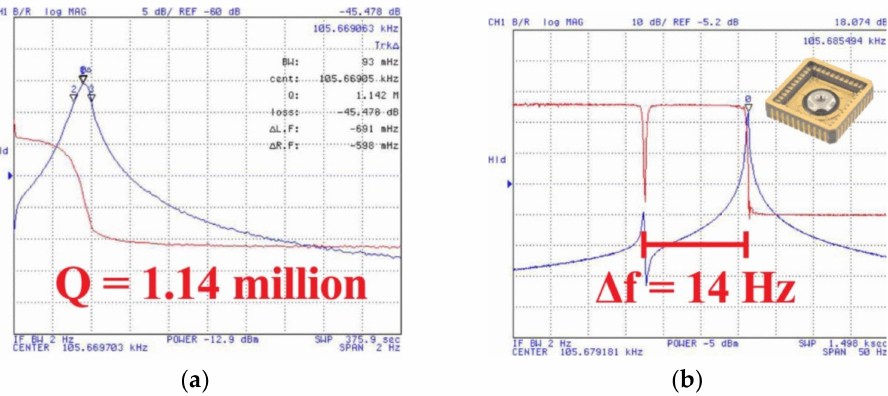
Figure 10. Performance of the HRG (Senkal et al. [75]) © 2022 IEEE. Reprinted, with permission from IEEE from D. Senkal, M. J. Ahamed, M. H. Asadian Ardakani, S. Askari and A. M. Shkel, “Demonstration of 1 million Q-factor on microglassblown wineglass resonators with out-of-plane electrostatic transduction”, Journal of Microelectromechanical Systems, vol. 24, no. 1, pp. 29–37, 2014. ( a ) Q-factor and ( b ) Frequency